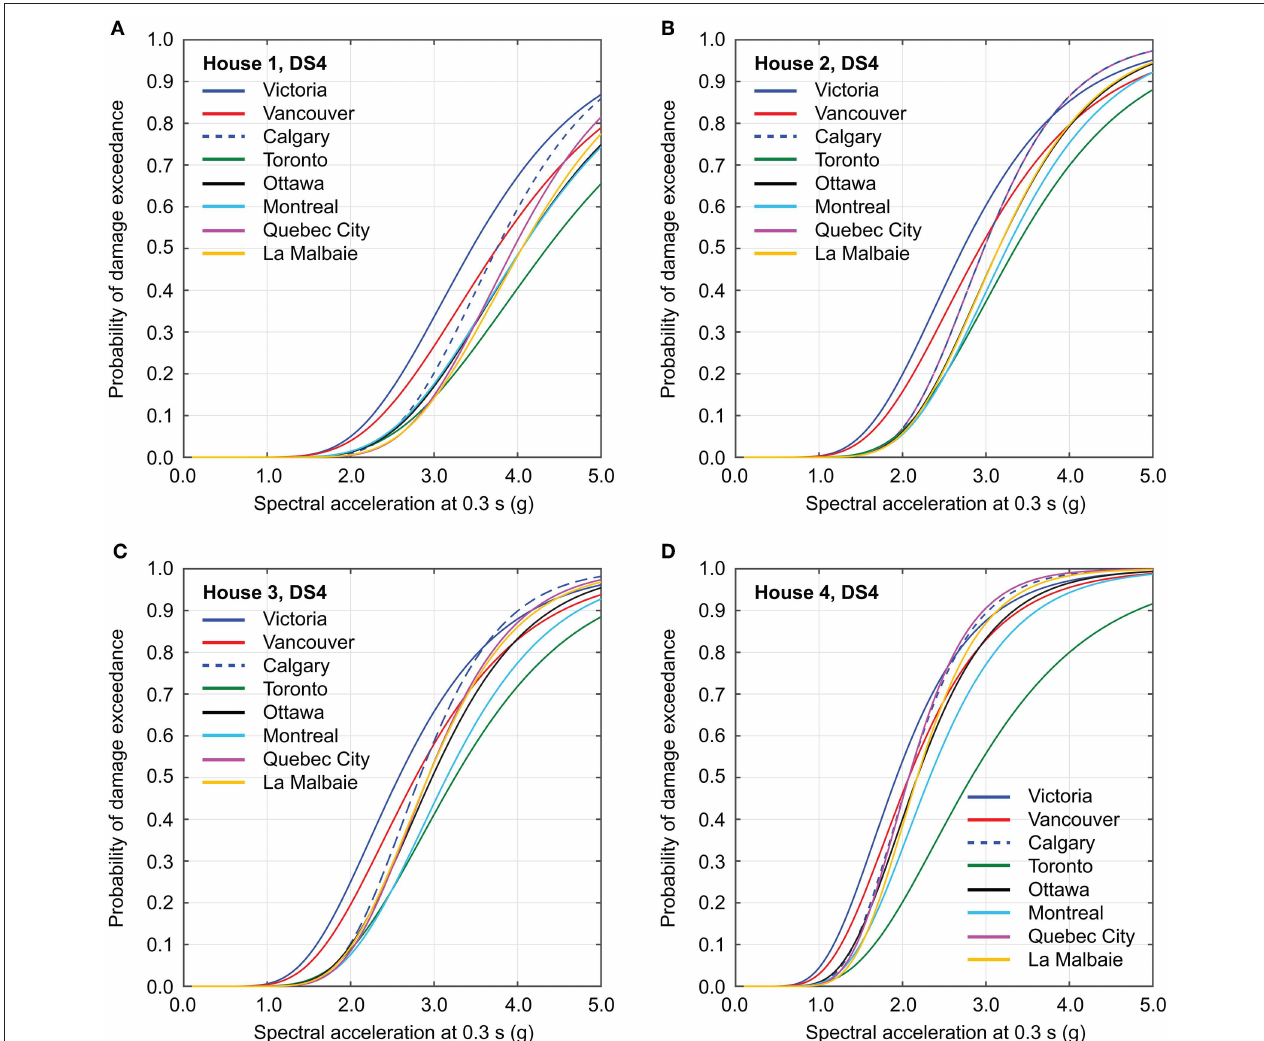
FIGURE 10 | Seismic fragility functions for the damage state 4 (collapse) for eight major cities: (A) House 1, (B) House 2, (C) House 3, and (D) House 4.